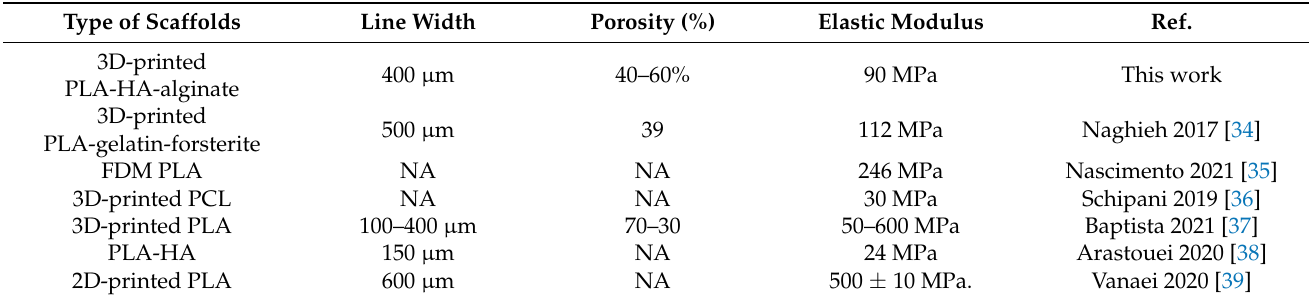
Table 2. Comparison of a similar